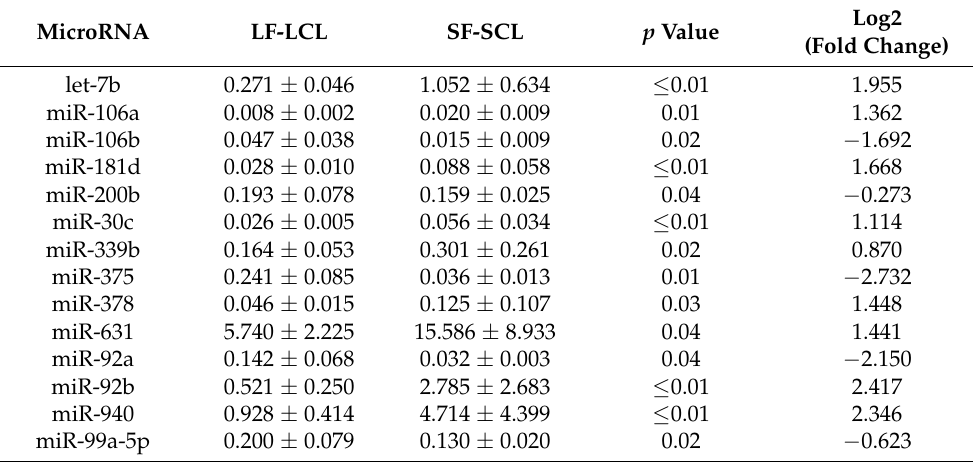
Table 1. Relative abundance of differentially expressed microRNAs in ampulla of LF-LCL and SF-SCL groups ( n = 6). Fold changes were the ratio of the mean expression values of SF-SCL/LF-LCL.